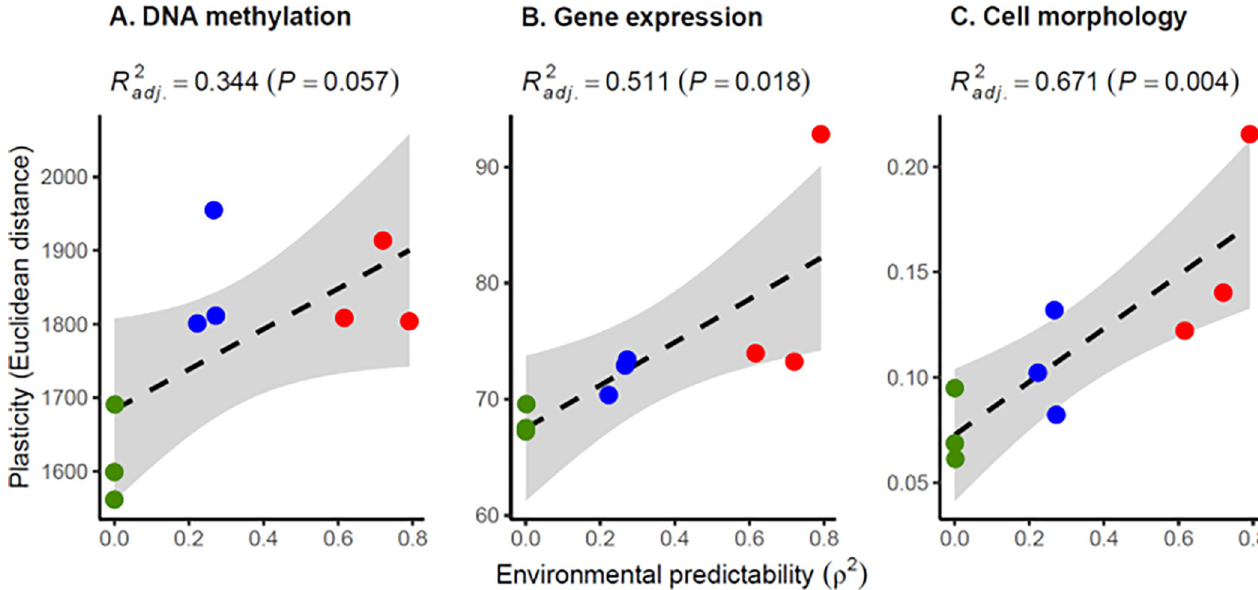
Fig 5. Multilevel evolution of plasticity in response to environmental predictability. The degree of plasticity of populations, as measured by the Euclidean distance between low and high salinities for ( A ) DNA methylation patterns at CpG context, ( B ) gene expression levels, and ( C ) cell morphology, is plotted against the predictability ρ 2 of the environmental fluctuations that these populations have experienced during experimental evolution. The dashed line is the regression slope, and the gray area represents the 95% confidence interval of the linear regression. The raw data underlying this figure are available in the Figshare repository https://doi.org/10.6084/m9.figshare.21905670.